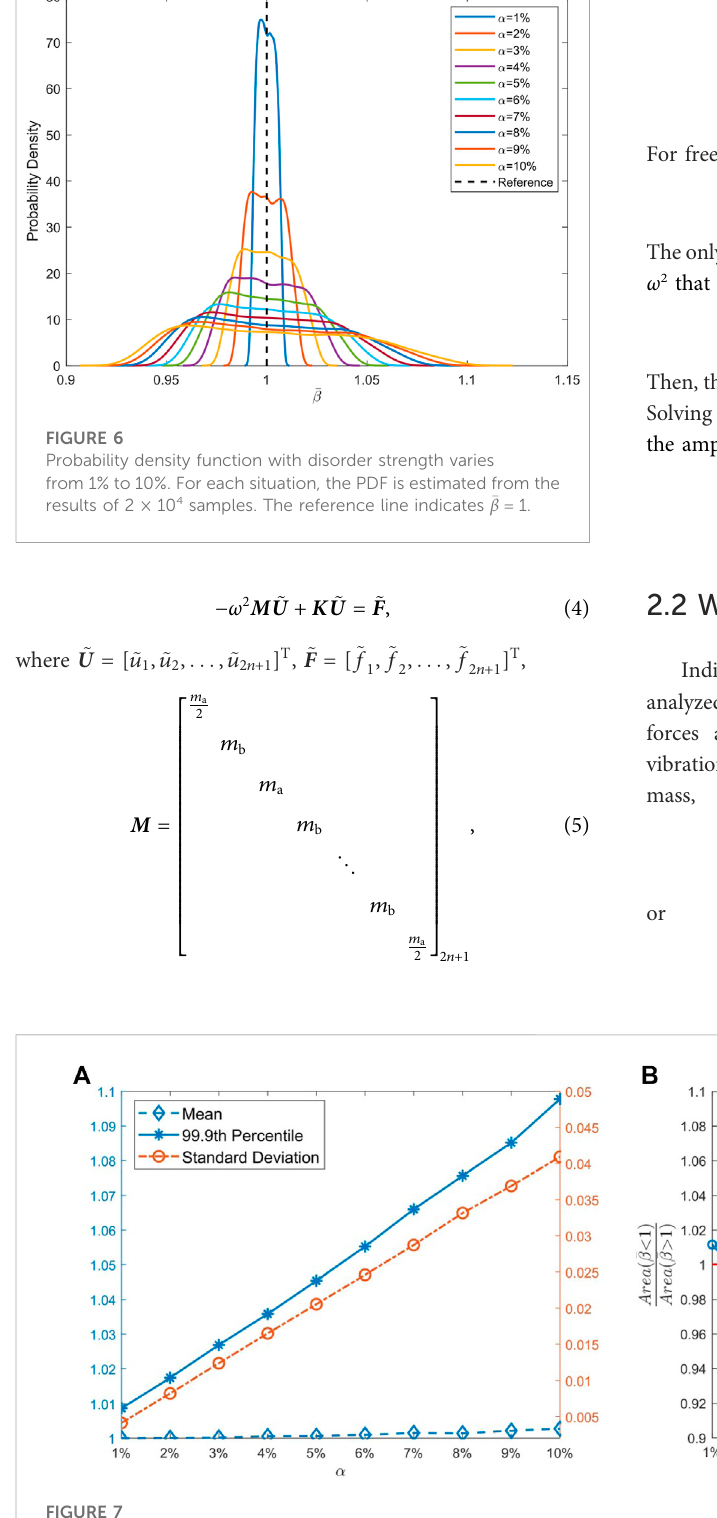
FIGURE 7 Statisticalcharacteristicswithdifferentdisorderstrength. (A) Variationofmeans,99.9thpercentiles,andstandarddeviations. (B) Ratioofareasat two sides of the reference line in